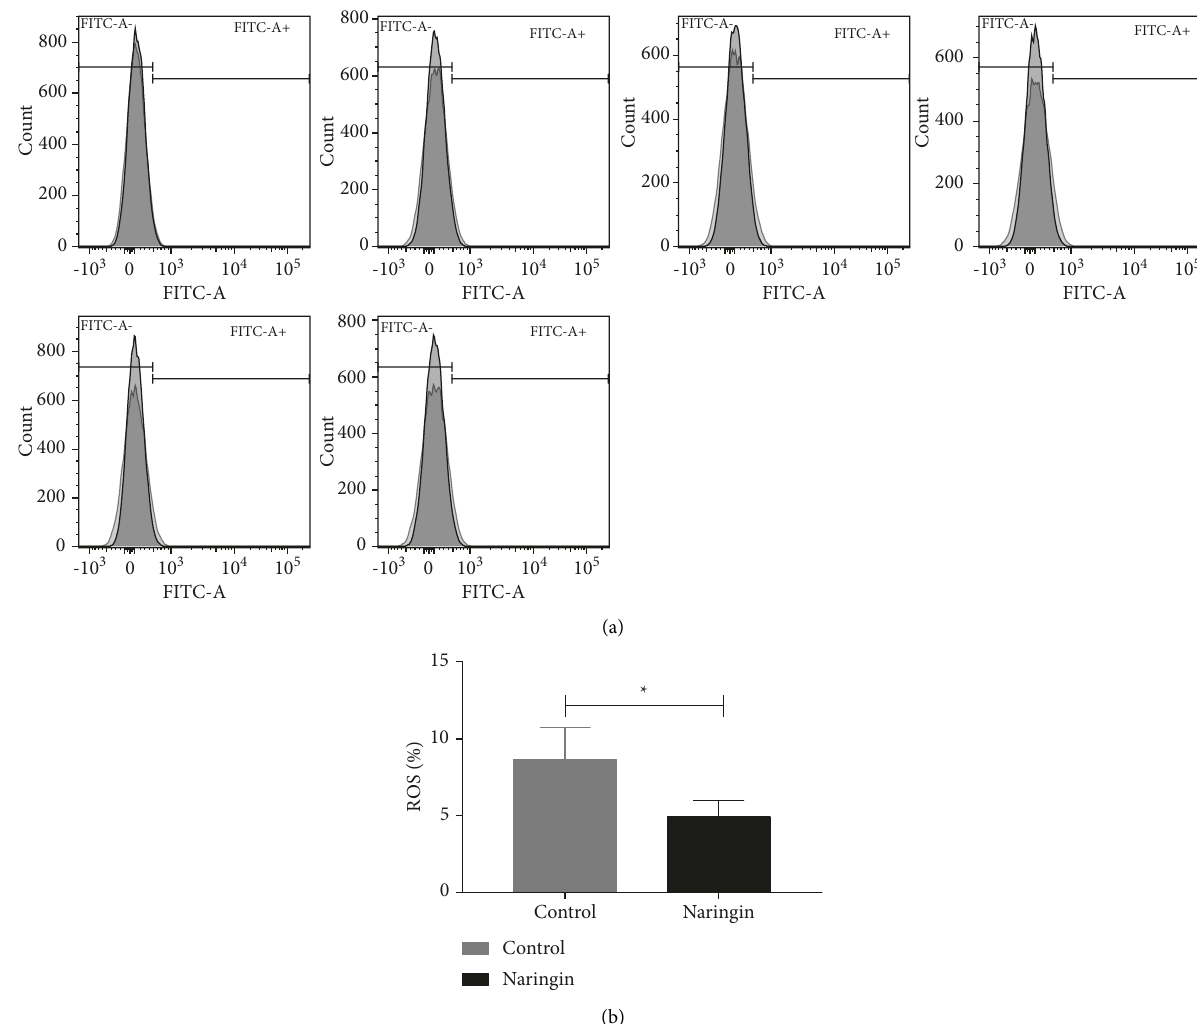
Figure 4: (a) Flow cytometry histograms of ROS assays in packed RBCs. The RBCs were stored at 4 ° C for 35 days with naringin solution or equal volume of PBS. (b) ROS of packed RBCs at 35 days. ∗ signifies p < 0 . 05 vs control